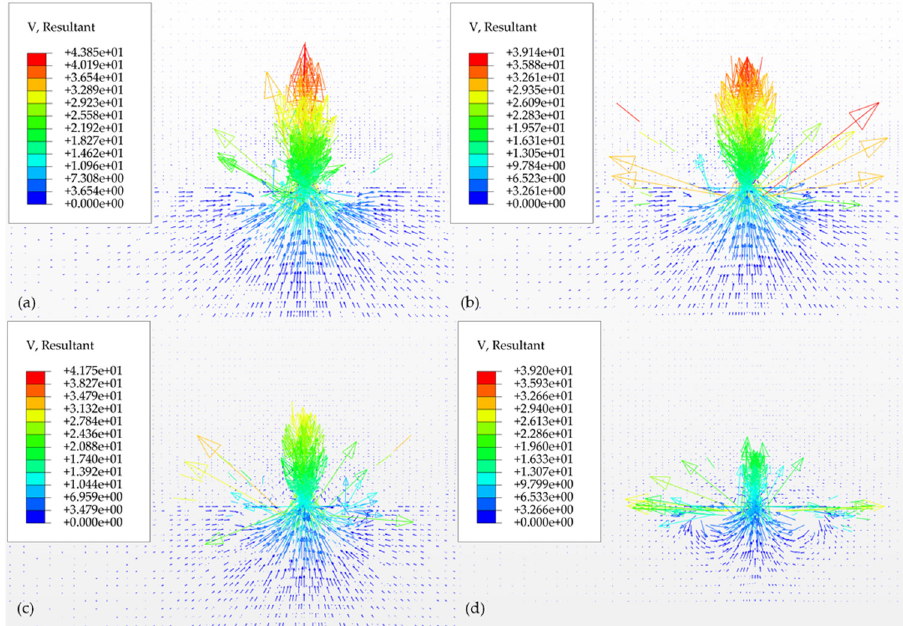
Figure 16. Simulated bubble motion during the collapse phase at: ( a ) t = 7.3 ms; ( b ) t = 7.35 ms; ( c ) t = 7.4 ms; ( d ) t = 7.45 ms; ( e ) t = 7.55 ms; and ( f ) t = 7.9 ms. Figure 17. Velocity field in the bubble area during the collapse phase at: ( a ) t = 7.0 ms; ( b ) t = 7.4 ms; ( c ) t = 7.45 ms; and ( d ) t = 7.55 ms.